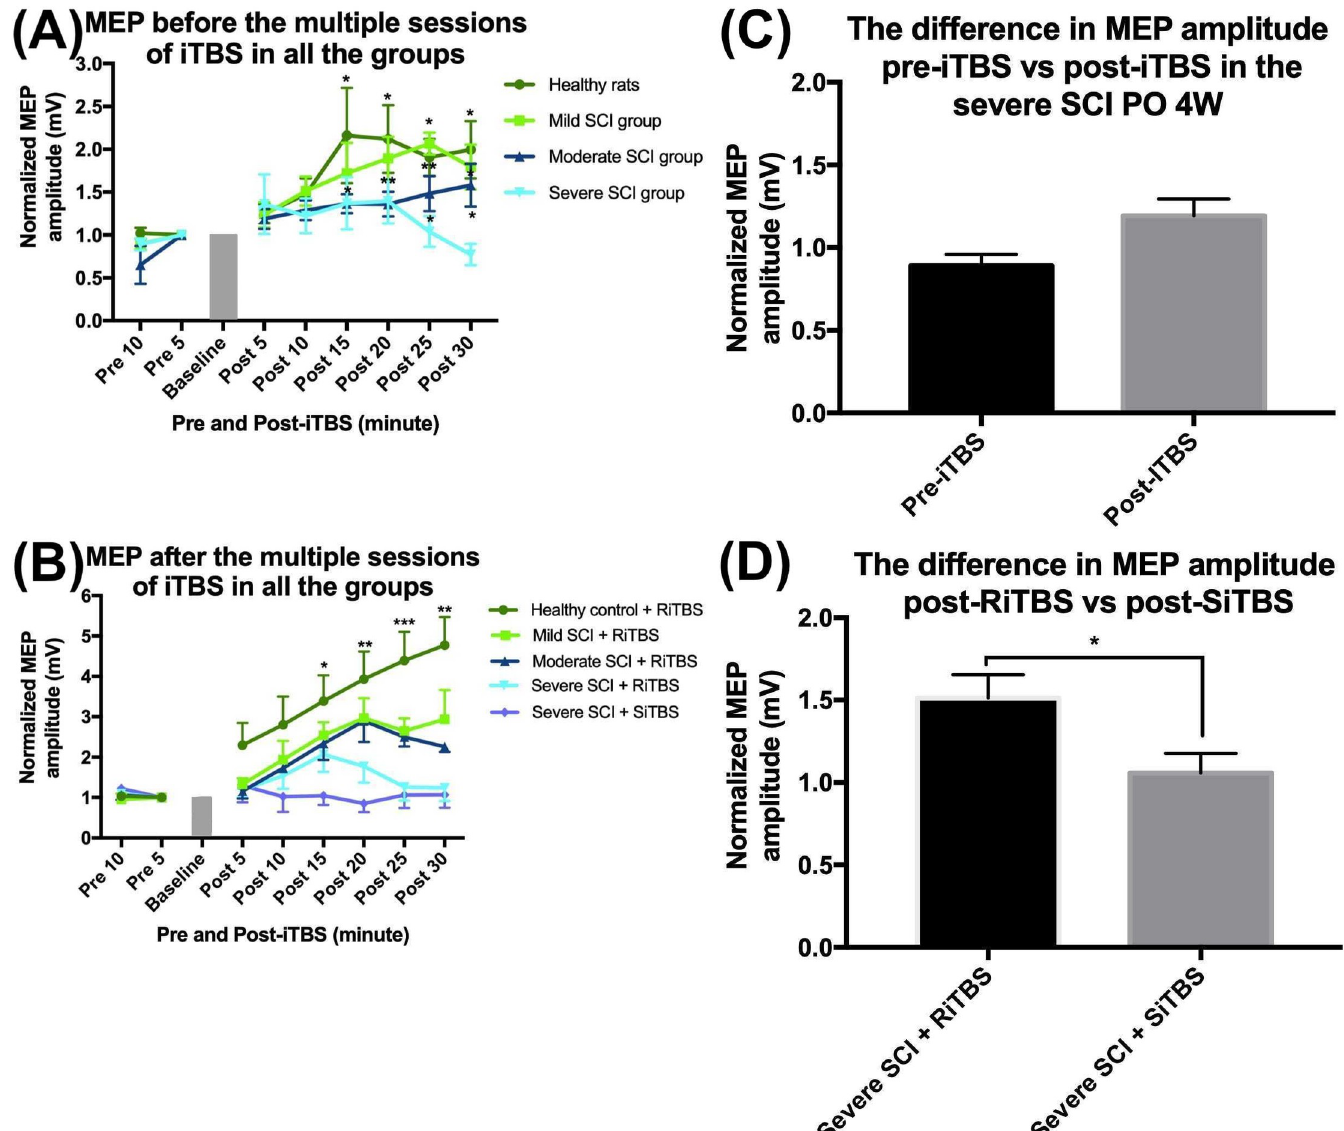
Fig 4. Effects of multiple sessions of intermittent theta-burst stimulation (iTBS) on the motor-evoked potential (MEP) amplitude. Before the multiple sessions of iTBS, the MEP amplitude had increased in the healthy control group and showed less facilitation in the spinal cord injury (SCI) groups (A). After multiple sessions of iTBS, the MEP amplitude increased in all real stimulation groups but was less facilitated in the sham stimulation group, and the effects of iTBS in the five groups significantly differed from each other (B). There was no significant difference between MEP amplitudes pre- and post-iTBS in the severe-SCI group at postoperative 4 weeks (PO 4W) (C). There was a significant difference between the MEP amplitude in the severe-SCI group + RiTBS and severe-SCI group + SiTBS at PO 6W (D). � p < 0.05, �� p < 0.01, ��� p < 0.001, by post-hoc Fisher’s LSD test on the MEP size between each time point post-SCI compared to the